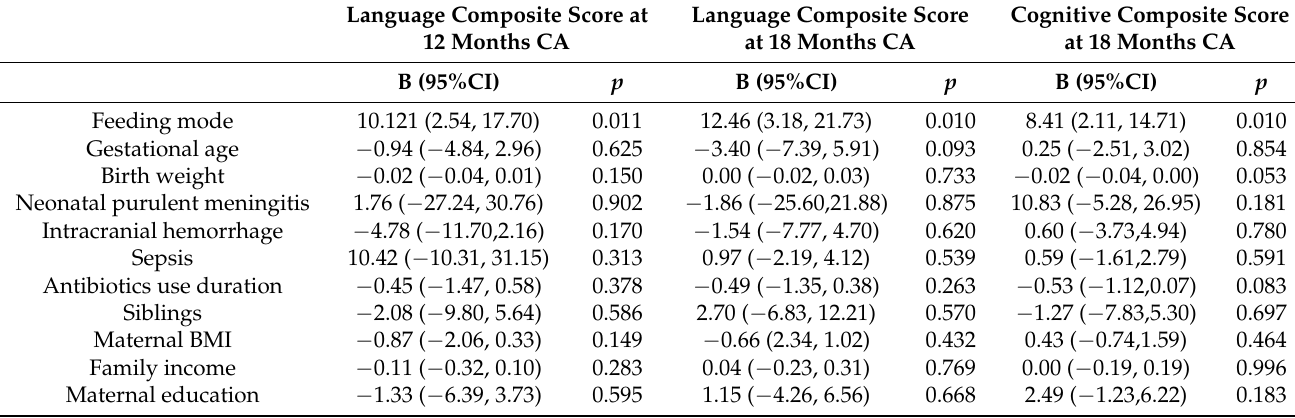
Table 5. Associations of feeding mode, gestational age, birth weight, neonatal purulent meningitis, intracranial hemorrhage, sepsis, family income and maternal education level with language composite score at 12 and 18 months CA and cognitive composite score at 18 months CA. Language Composite Score at Language Composite 12 Months CA